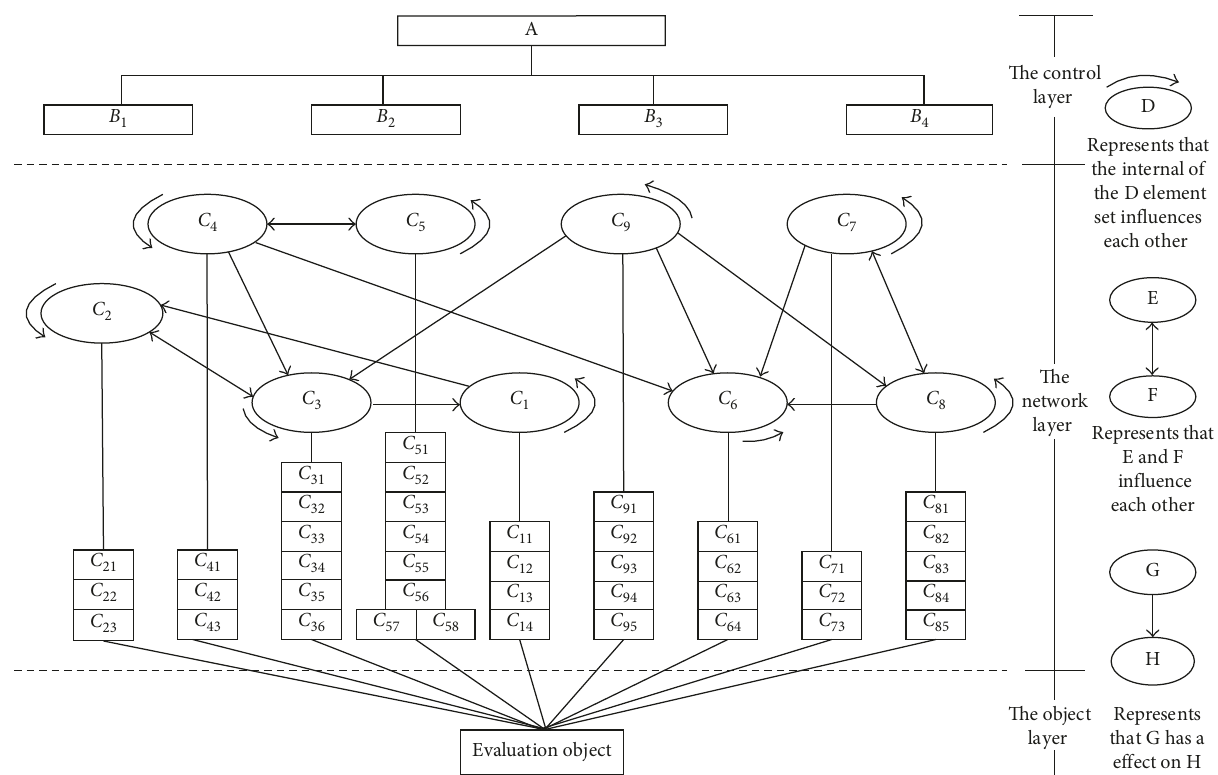
Figure 1: Network structure of the ANP for the food safety supervision in the sales